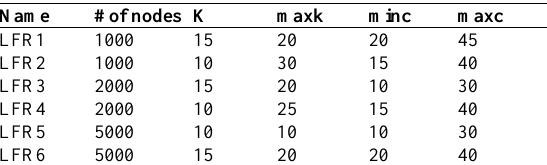
Table 3. Details of LFR artificial